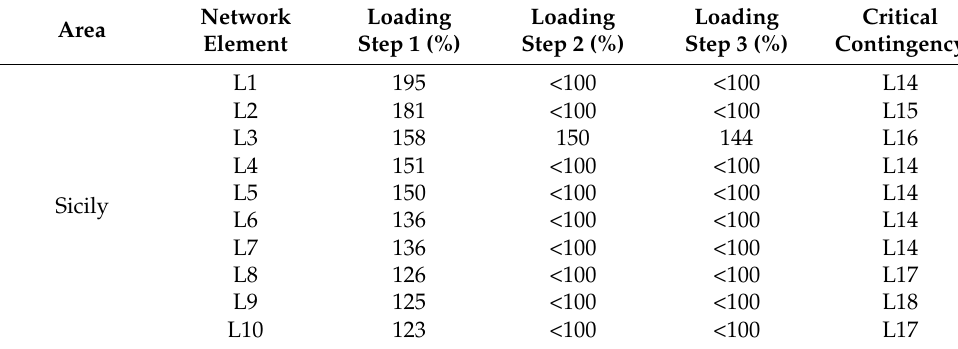
Table 7. Load flow results in N-1